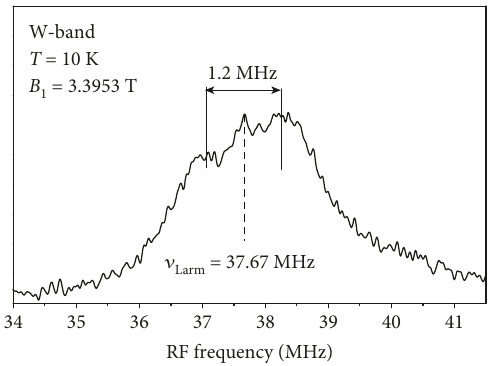
Figure 9: 27 Al ENDOR spectra for sample Q10 measured at B 3395 3mT